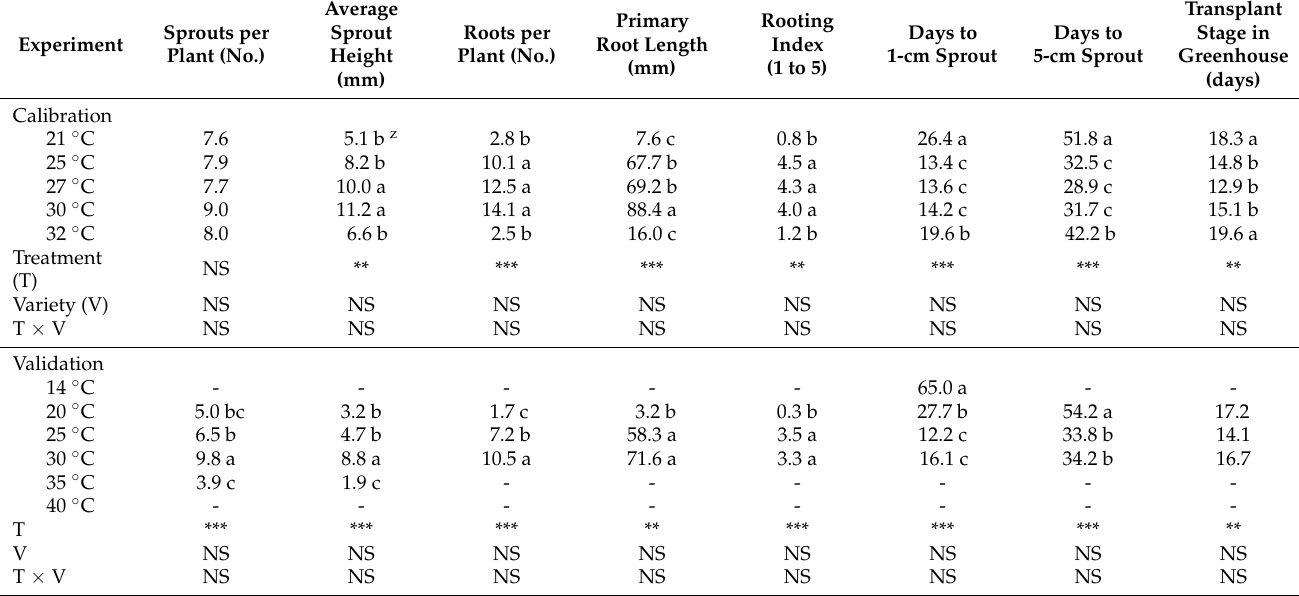
Table 2. Seed rhizome growth parameters measured from ’Bubba Blue’ and ’Madonna’ ginger sprouted under different temperatures inside dark incubators and then grown in a greenhouse in two experimental phases. Sprouts per Experiment Plant